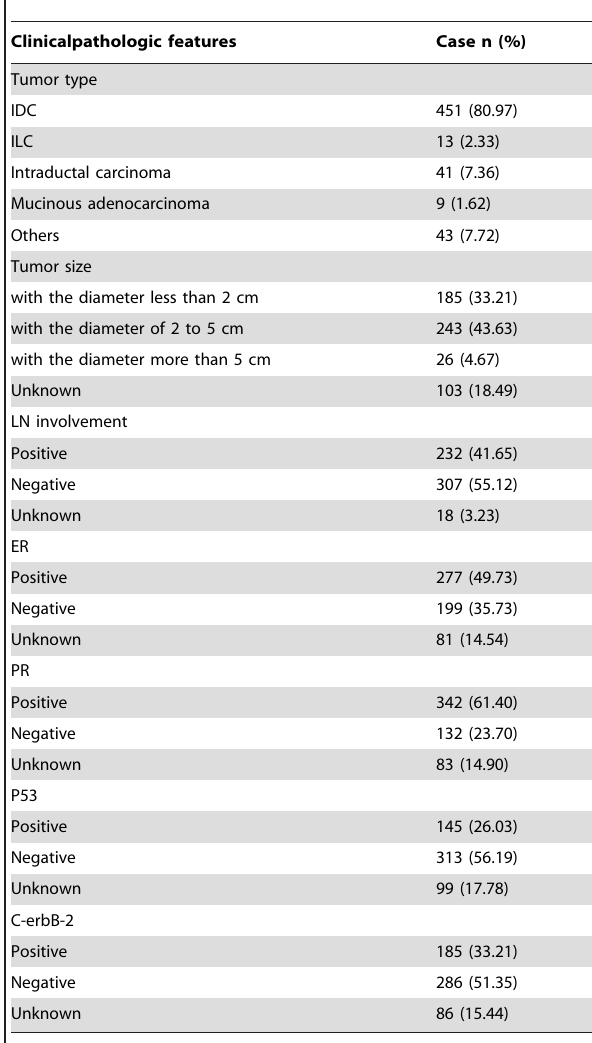
Table 1. Clinicalpathologic features of breast cancer